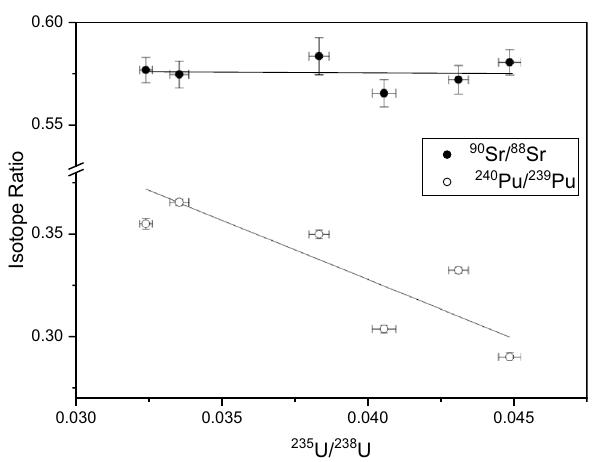
Figure 8. 240 Pu/ 239 Pu and 90 Sr/ 88 Sr vs. 235 U/ 238 U in six samples of spent fuel. Pu and U data are from ref. 1 . Uncertainties are